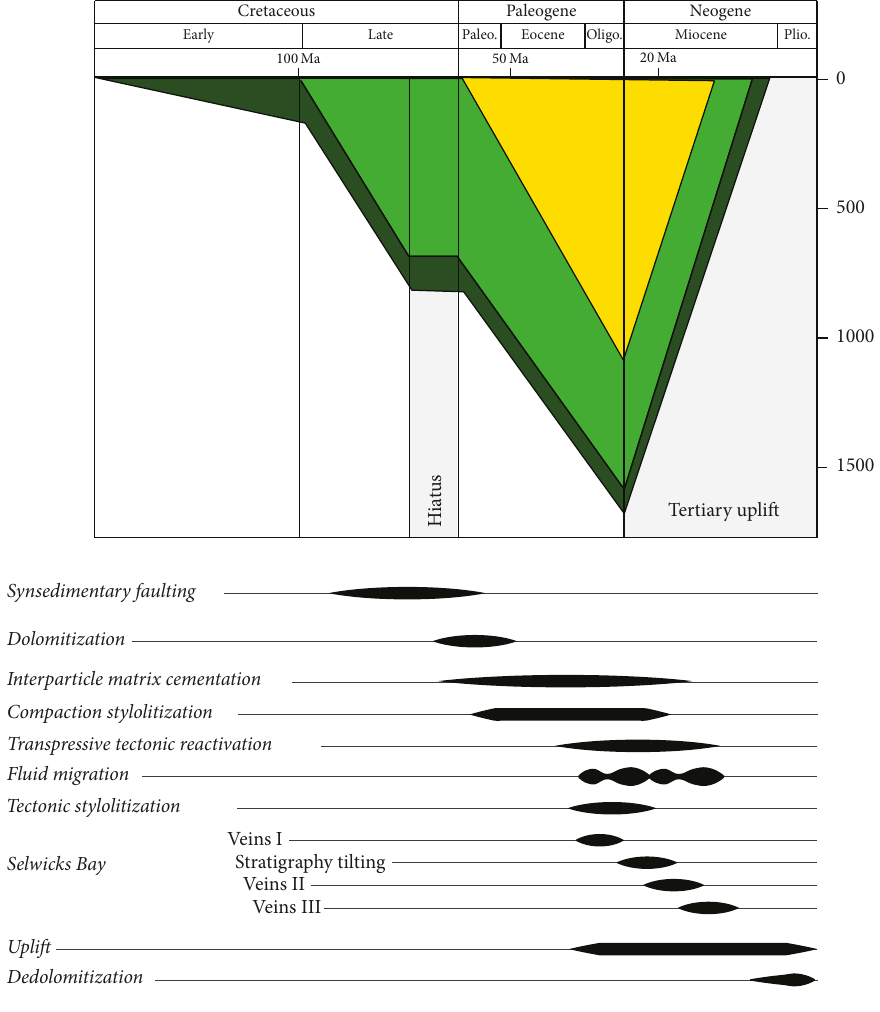
Figure 7: Relative timing of the diagenetic and fluid flow events affecting Chalk deposits in Flamborough Head